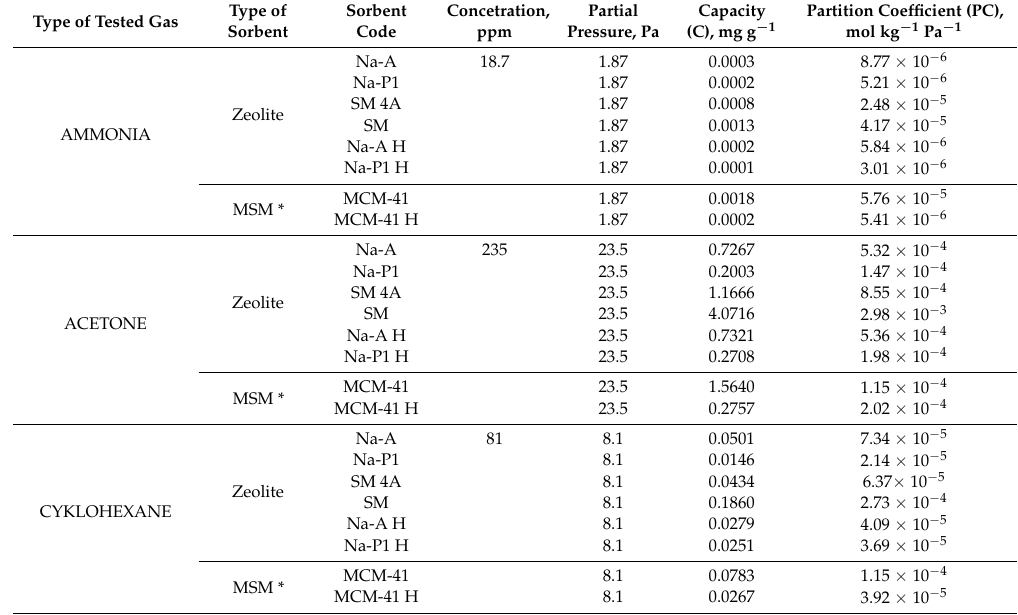
Table 3. Summary of data obtained for the assessment of the action of adsorbents used to remove ammonia, acetone, and cyclohexane from the